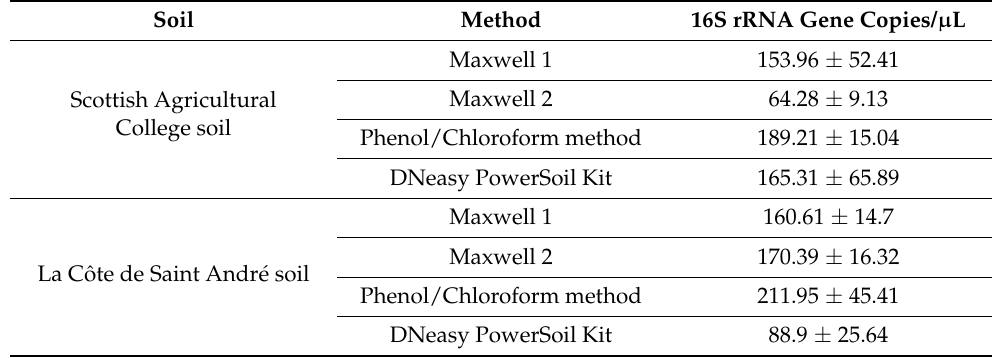
Table 2. 16S rRNA gene copy numbers from the Scottish Agricultural College (Craibstone, Scotland) and La C ô te de Saint Andr é (France) soils (250 mg) using different DNA extraction and purification strategies. Maxwell 1 and 2: modifications of the prototype Maxwell RSC Fecal Microbiome DNA Kit (Promega). All data (averages and standard deviations) are based on three separate soil samples for each